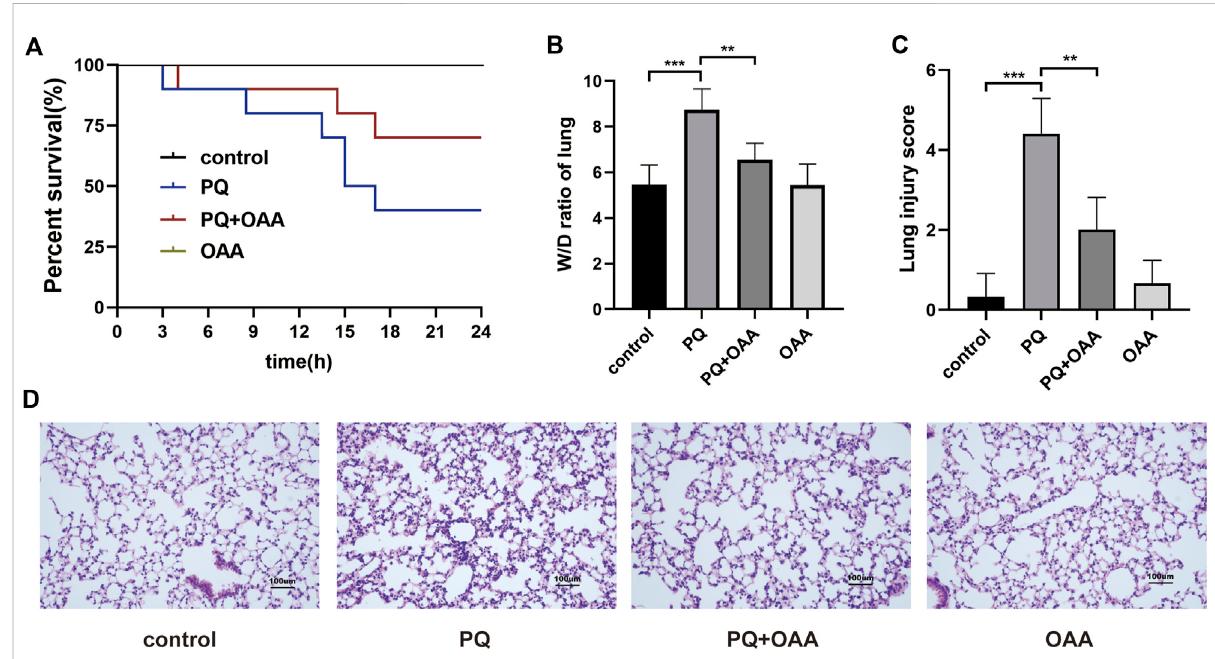
FIGURE 1 ProtectiveeffectofOAAinmiceafterPQpoisoning. (A) Kaplan-Meiersurvivalcurve. (B) ThelungW/Dratio. (C) Lunginjuryscore. (D) HEstaining of mice lung tissue ( × 200). Data are presented as mean ± SD ( n = 6). * p ＜ 0.05, ** p ＜ 0.01, *** p ＜ 0.001, **** p ＜ 0.0001. PQ, paraquat; OAA, oxaloacetate